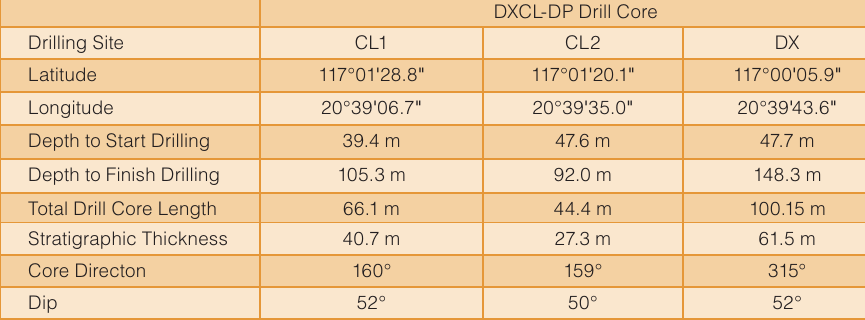
Table 1. Summary of logistical information on DXCL-DP drill